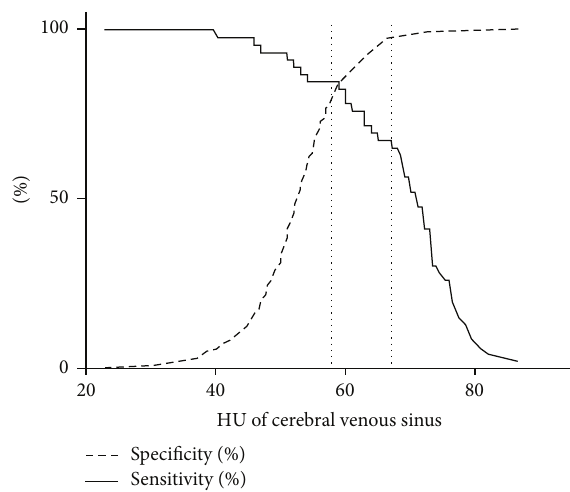
Figure 4: Graph demonstrating changes in sensitivity and speci- ficity at different HU cutoffs for standardised HU measurement. The dotted lines represent our proposed HU cutoffs with high negative and positive predictive values for venous sinus